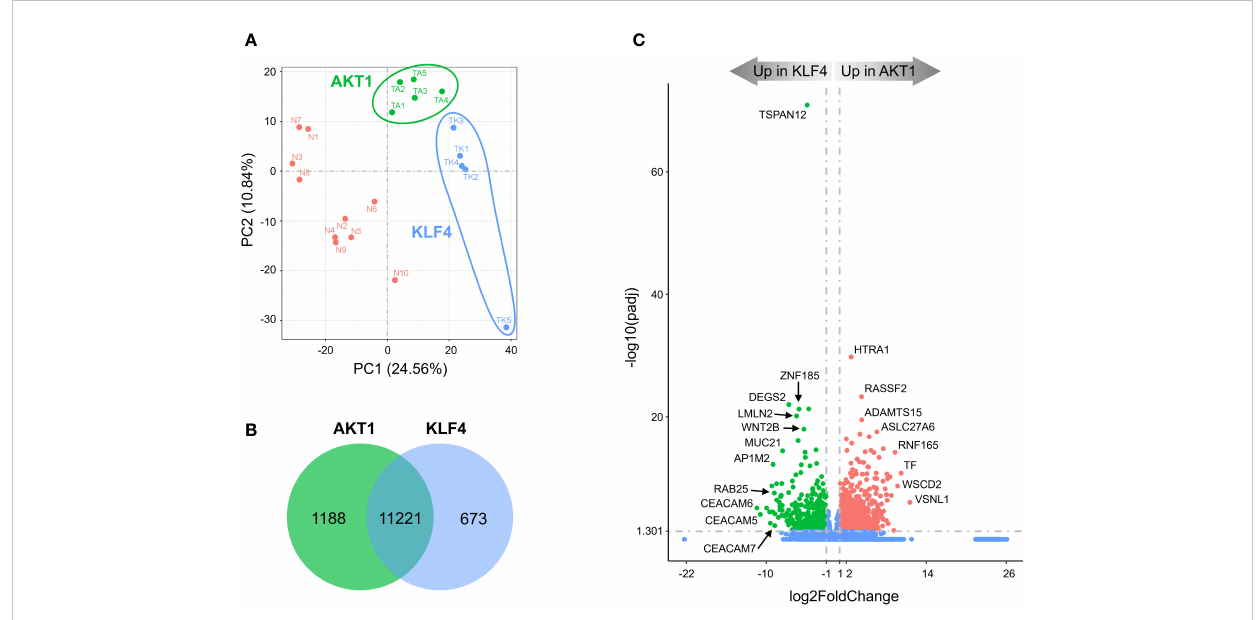
FIGURE 3 Divergent transcriptomes within TRAF7 group of tumors: AKT1 and KLF4 meningiomas. (A) PCA plot of RNA-seq analysis in primary TRAF7 meningiomas carrying additional mutations in AKT1 or KLF4. Five samples were analyzed in each group. Sample clusters are shown by different colors (KLF4 in blue, AKT1 in green) and circled by corresponding color lines. (B) Venn diagram showing the overlap of DEGs in AKT1 and KLF4 meningiomas by RNA-seq analysis. Common and tumor genotype-speci fi c genes are depicted by numbers inside the corresponding circles. (C) Volcano plot visualizing signi fi cant DEGs in AKT1 vs. KLF4 meningiomas: relative expression (x-axis) vs. statistical signi fi cance (y-axis) of difference in mRNA expression. Genes which are not differentially expressed are shown in